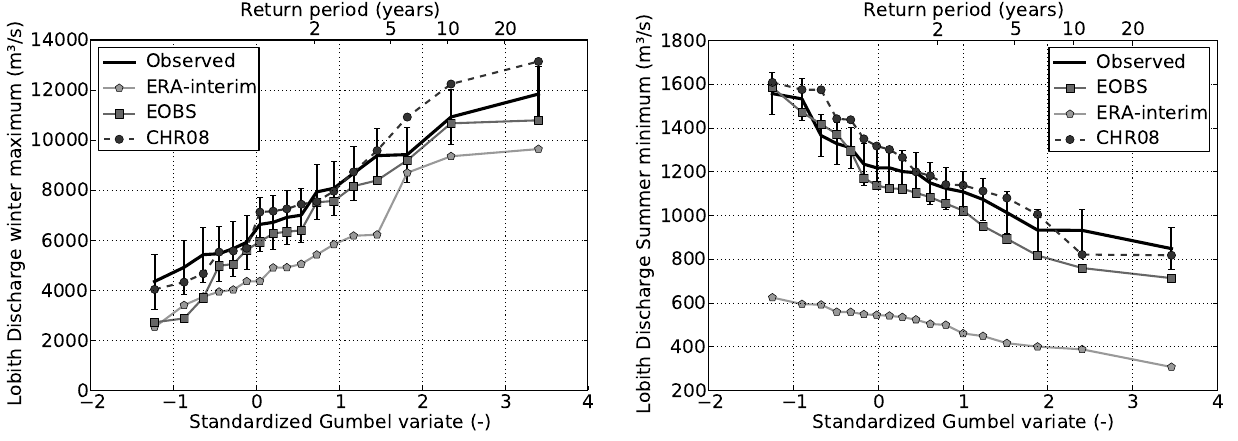
Fig. 6. Gumbel plot for CHR08, E-OBS, ERA-Int and observed winter maximum (left panel) and summer minimum (right panel) discharges and the 95% confidence interval for the observed discharges at Lobith for the period 1990–2008.